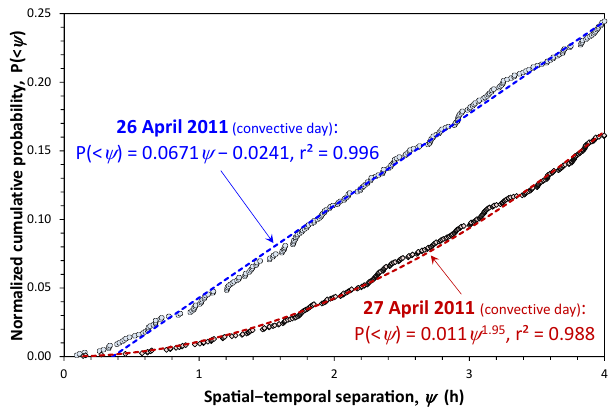
Figure 10. Tornado outbreak on 26–27 April 2011. Normalized cu- mulative probability P (< ψ ) of spatial–temporal separations ψ be- tween pairs of severe tornado (path length L ≥ 10km) touchdowns during tornado outbreaks in the USA on 26 and 27 April 2011 (con- vective days; see Figs. 2 and 3). Cumulative probabilities are given for spatial–temporal separations ψ <4h. The least-square best-fit line (blue dashed line) and power law (red dashed line) to the data are shown in this figure for 26 and 27 April 2011 respectively. Data were obtained from NOAA